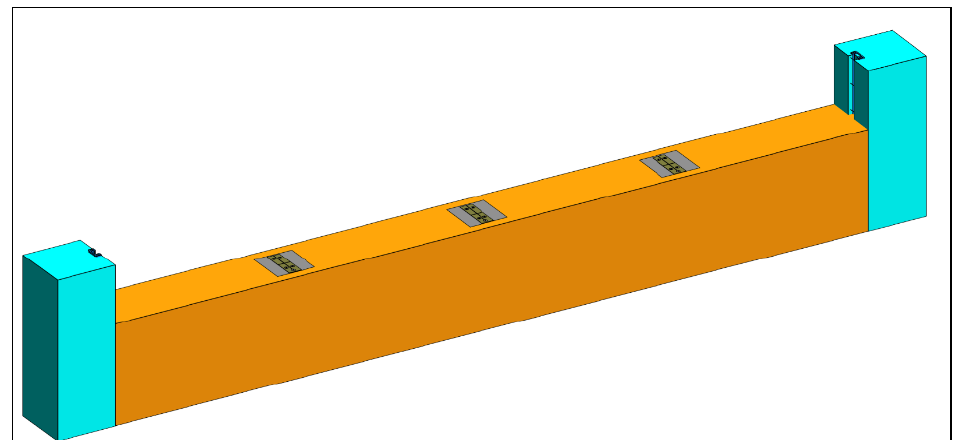
Figure 8. BIM model of center post and end post. ( a ) Center post, ( b ) end post.